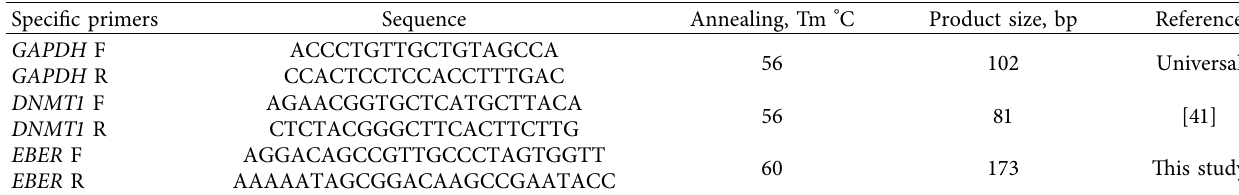
Table 3: Specific primers of the DNMT1 gene in real-time RT